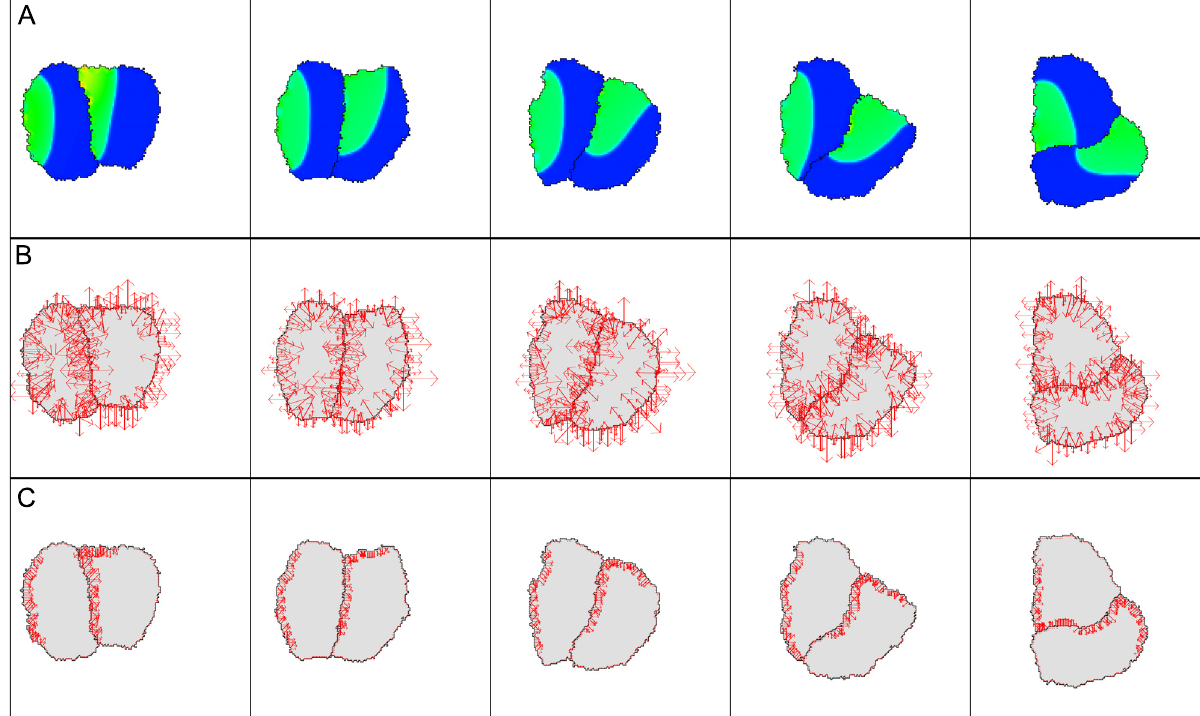
Fig 8. Edge forces in two adhering cells with internal signaling. (A) The level u of signaling activity (colors range from blue (low levels), to green, to red (high levels)), (B) total force exerted by each cell, (C) mutual forces due to signaling contraction alone. The cells polarize and circulate about one another. Parameters for the CPM are λ = 2, a = 2500, λ = 0, J (1, 0) = 30000 = J (1, 2), T = 200, β = 80 (for dH ). Parameters for the reaction-diffusion a p u system are provided in the Supporting Information S1 File. High signaling activity (red) leads to local edge contraction. The configurations are shown at MCS 80, 180, 280, 380 and